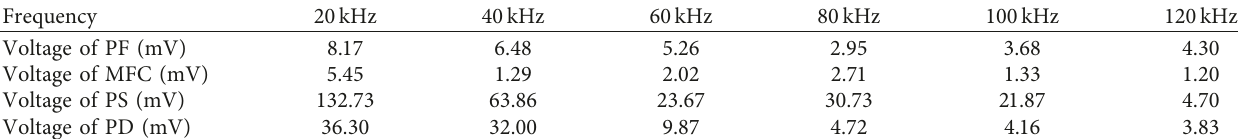
Table 2: Experimental maximum voltage amplitude of various piezoelectric sensors.